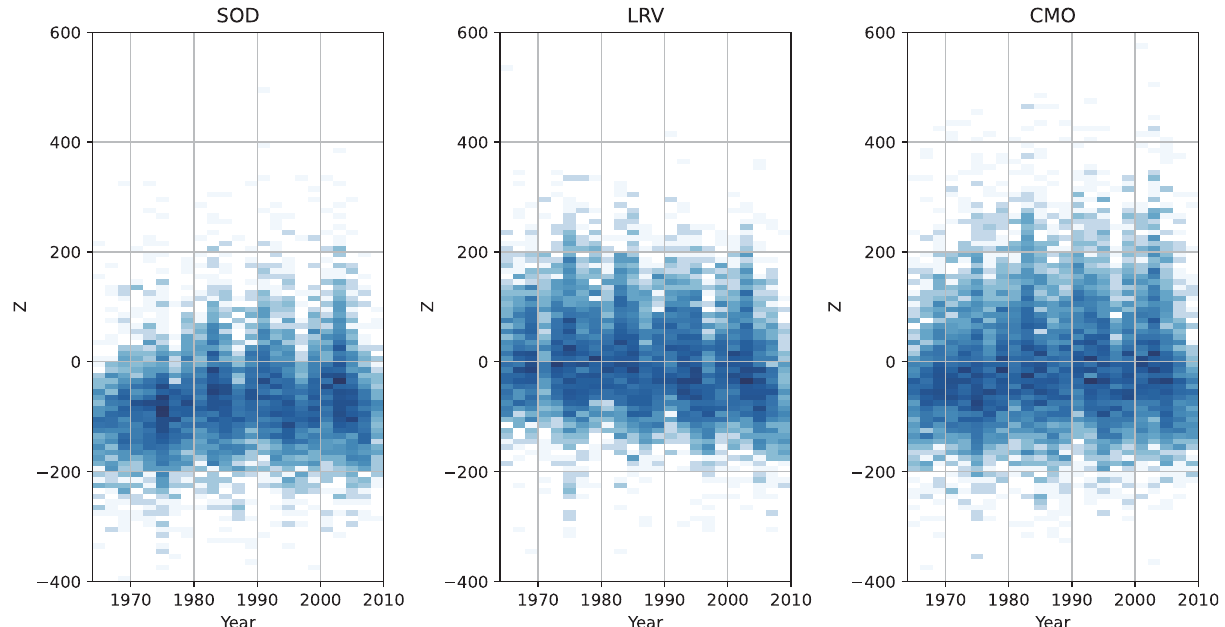
Fig. 2. Occurrence distribution of the Z component for the conditions of (cid:1) 50 nT (cid:3) Dst < 0 and H < (cid:1) 100 nT. SOD: 23 5 UT < 2 (left), LRV: 2 5 UT < 5 (middle), and CMO: 13 5 UT < 16 (right).